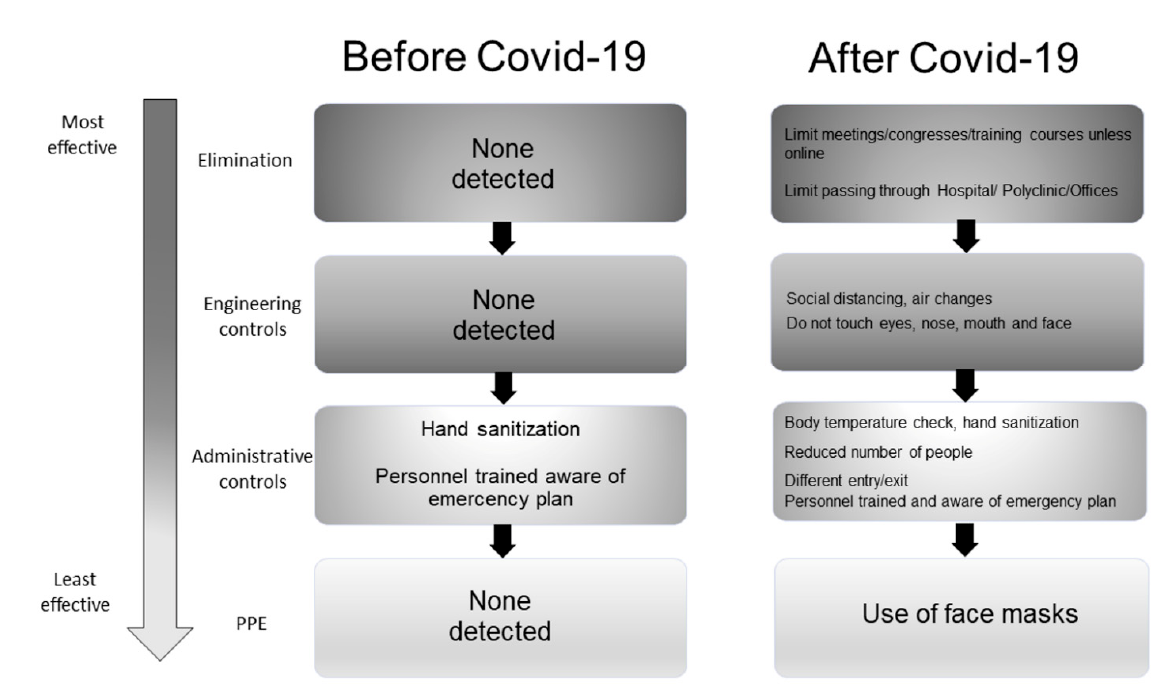
Figure 4. Hierarchy of Controls to identify the “general” best practices for COVID-19 control. Depicted with a vertical arrow list, the most effective controls are on the top side, whereas the least effective controls are on the bottom. Left part: existing measures; Right part: emergency measures.